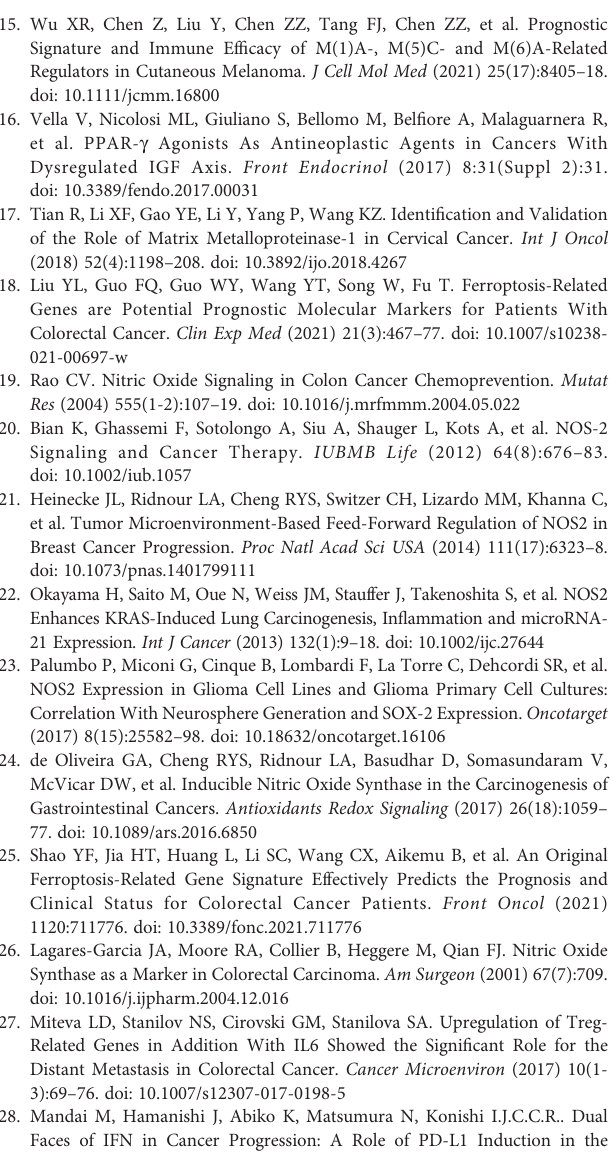
Supplementary Table 1 | DEGs expression results in left- and right- colorectal cancer. P < 0.05 and |log2 fold change (FC)| > 0.5.